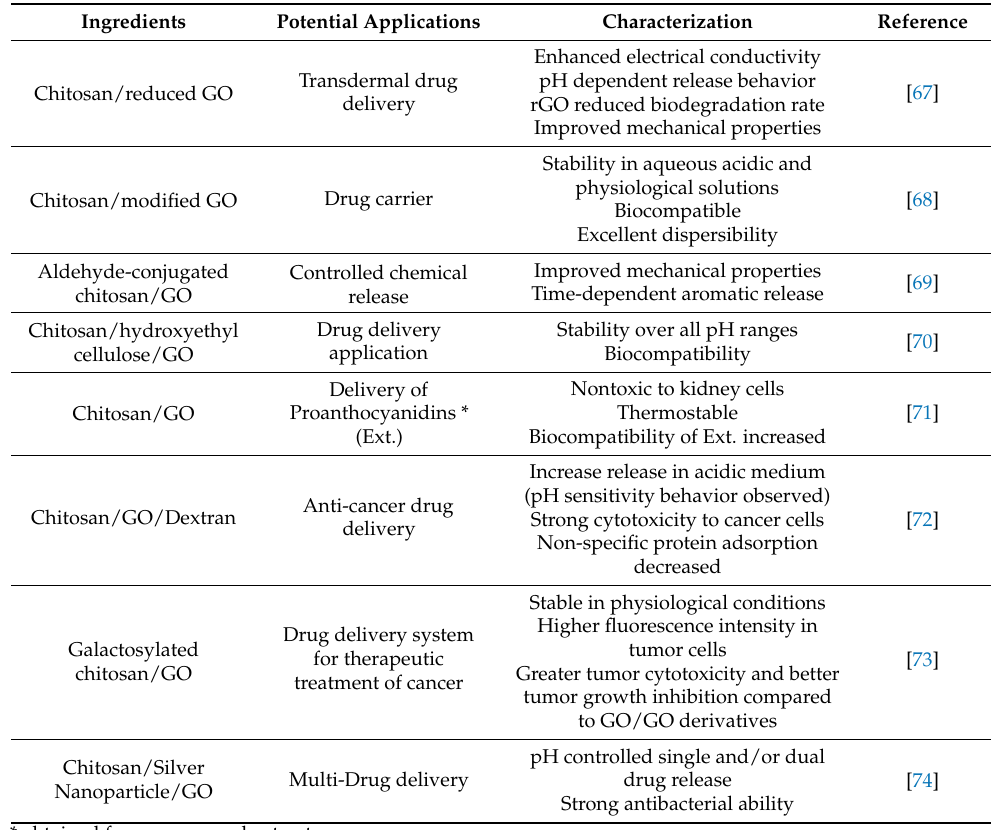
Table 3. Application of chitosan/GO films to serve as drug delivery systems.